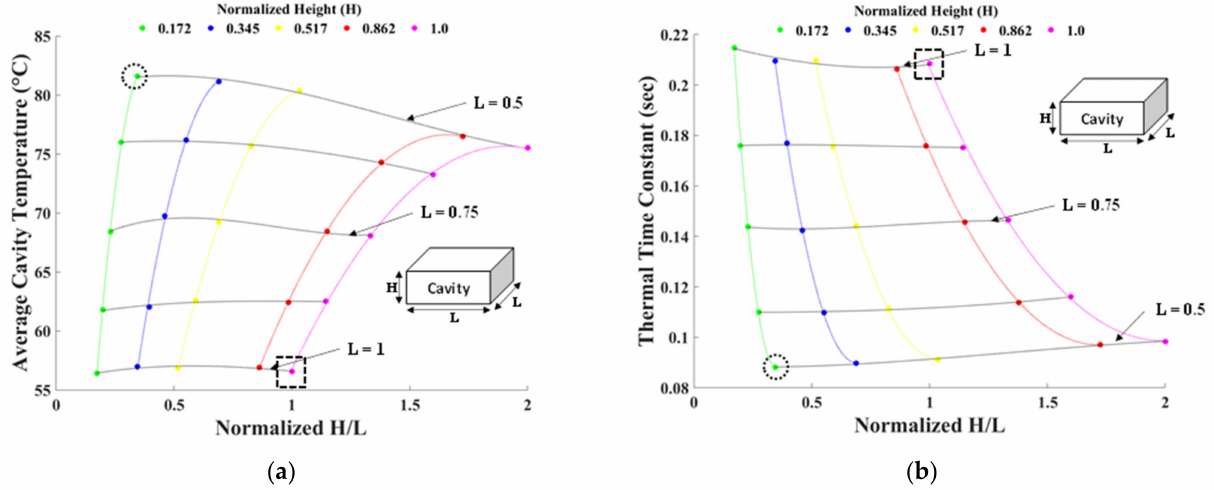
Figure 9. Cavity size design study results showing ( a ) the average cavity temperature and ( b ) the thermal time constant for decreasing cavity base dimension and cavity